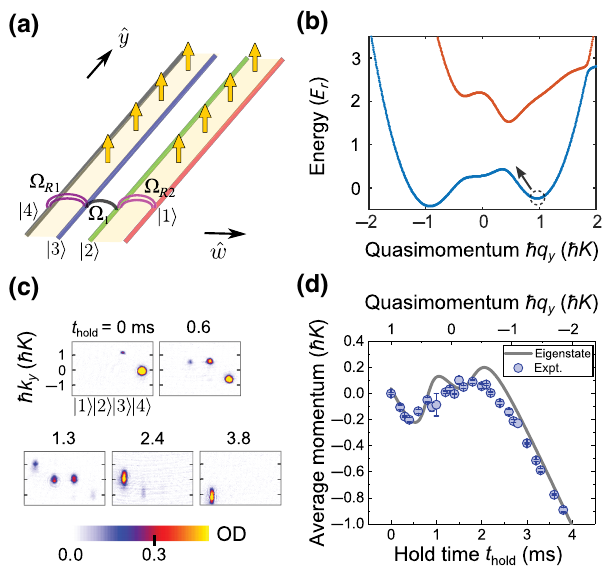
FIG. 8. Transport in a Hall strip. (a) Schematic of a Hall strip. (b) The single-particle dispersion. (c) Select TOF images for the quantum transport measurement with a BEC initially prepared around the minimum of the right well [dashed circle in (b)]. (d) Average momentum versus t hold and quasimomentum. Circles are experimental data (error bars are standard errors of typically five repetitive measurements). Solid lines are eigenstate